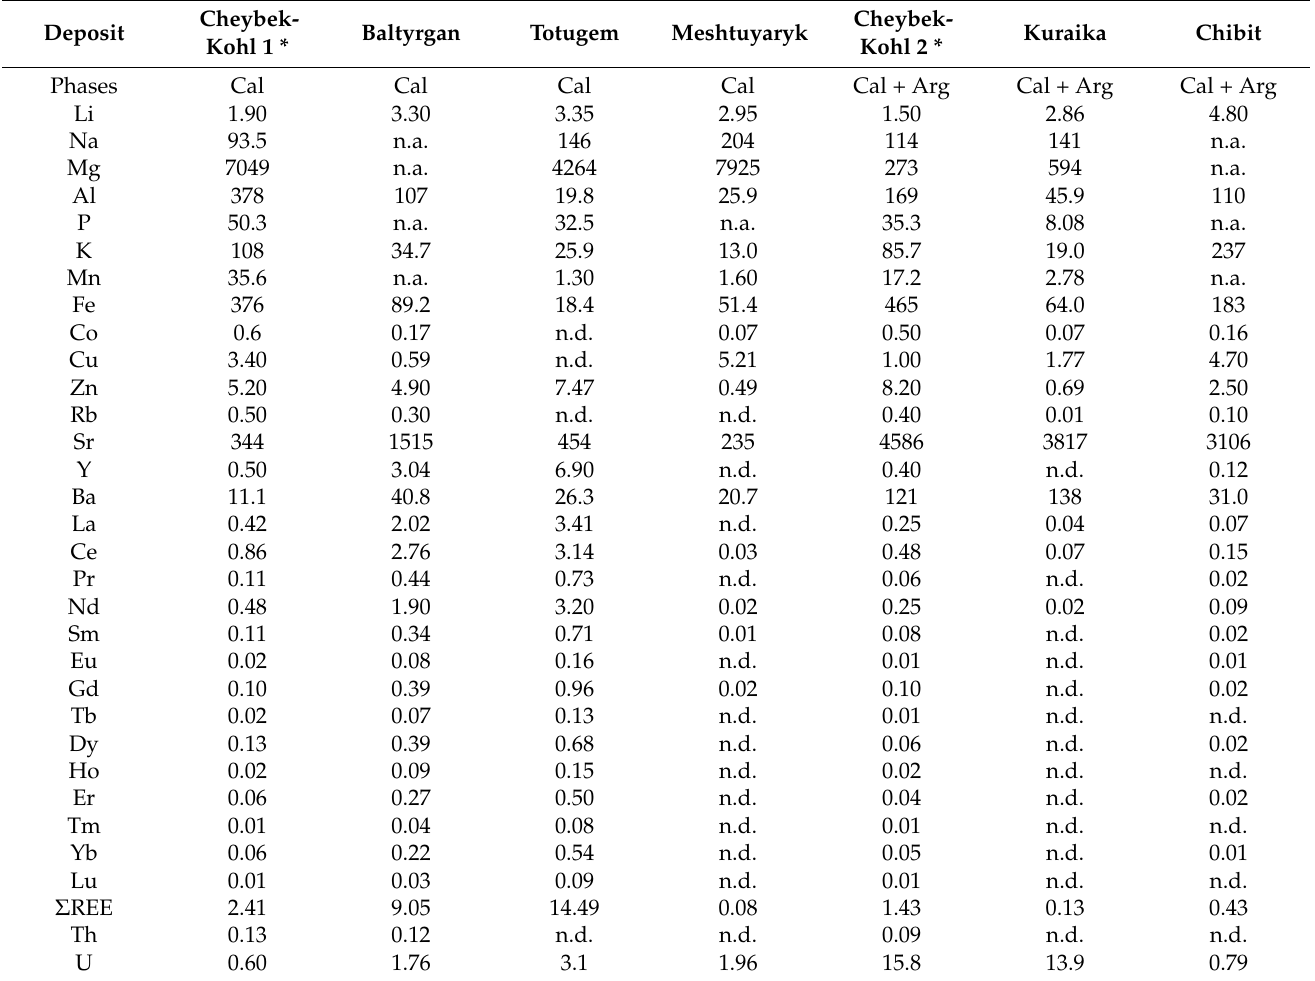
Table 3. Trace-element and REE concentrations (ICP-MS data, in ppm) in carbonate fractions extracted from travertines of the south-eastern Gorny